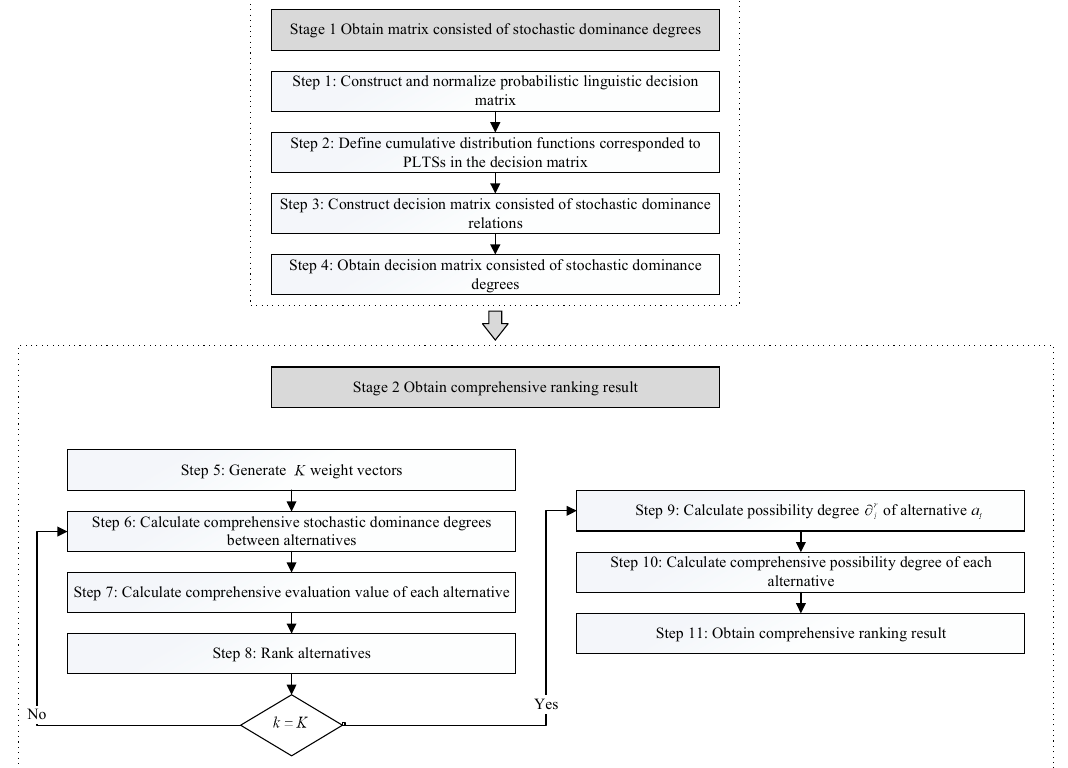
Figure 1. Procedure of the proposed approach.